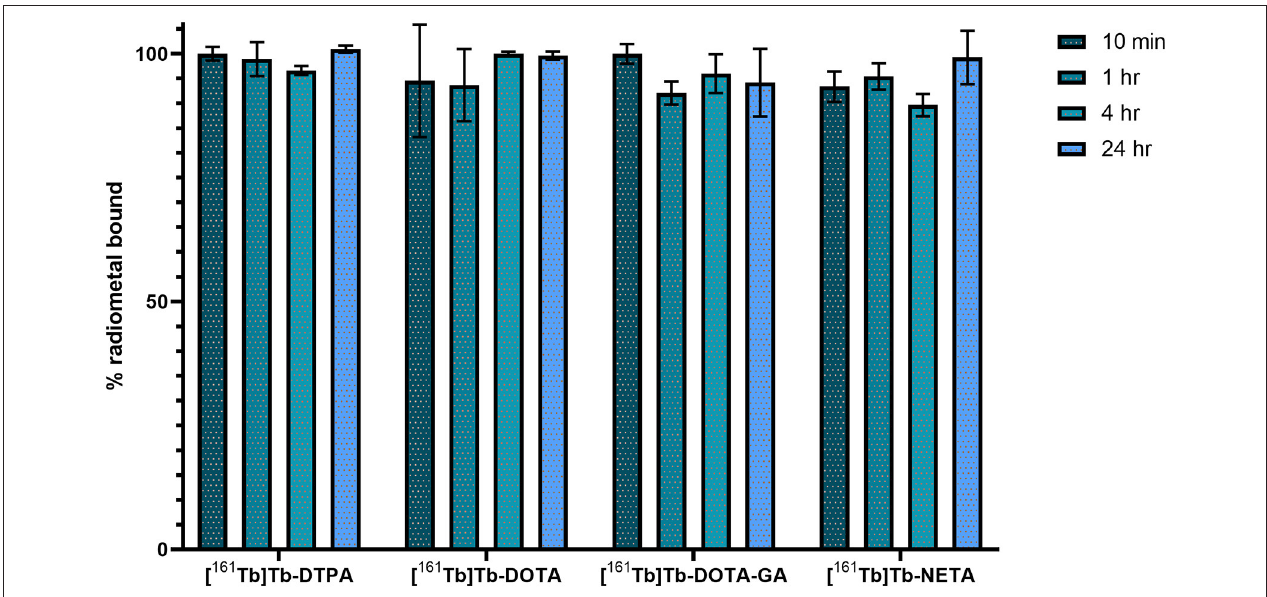
FIGURE 3 | In vitro stability of 161 Tb-radiolabeled complexes in PBS at 37 ◦ C.